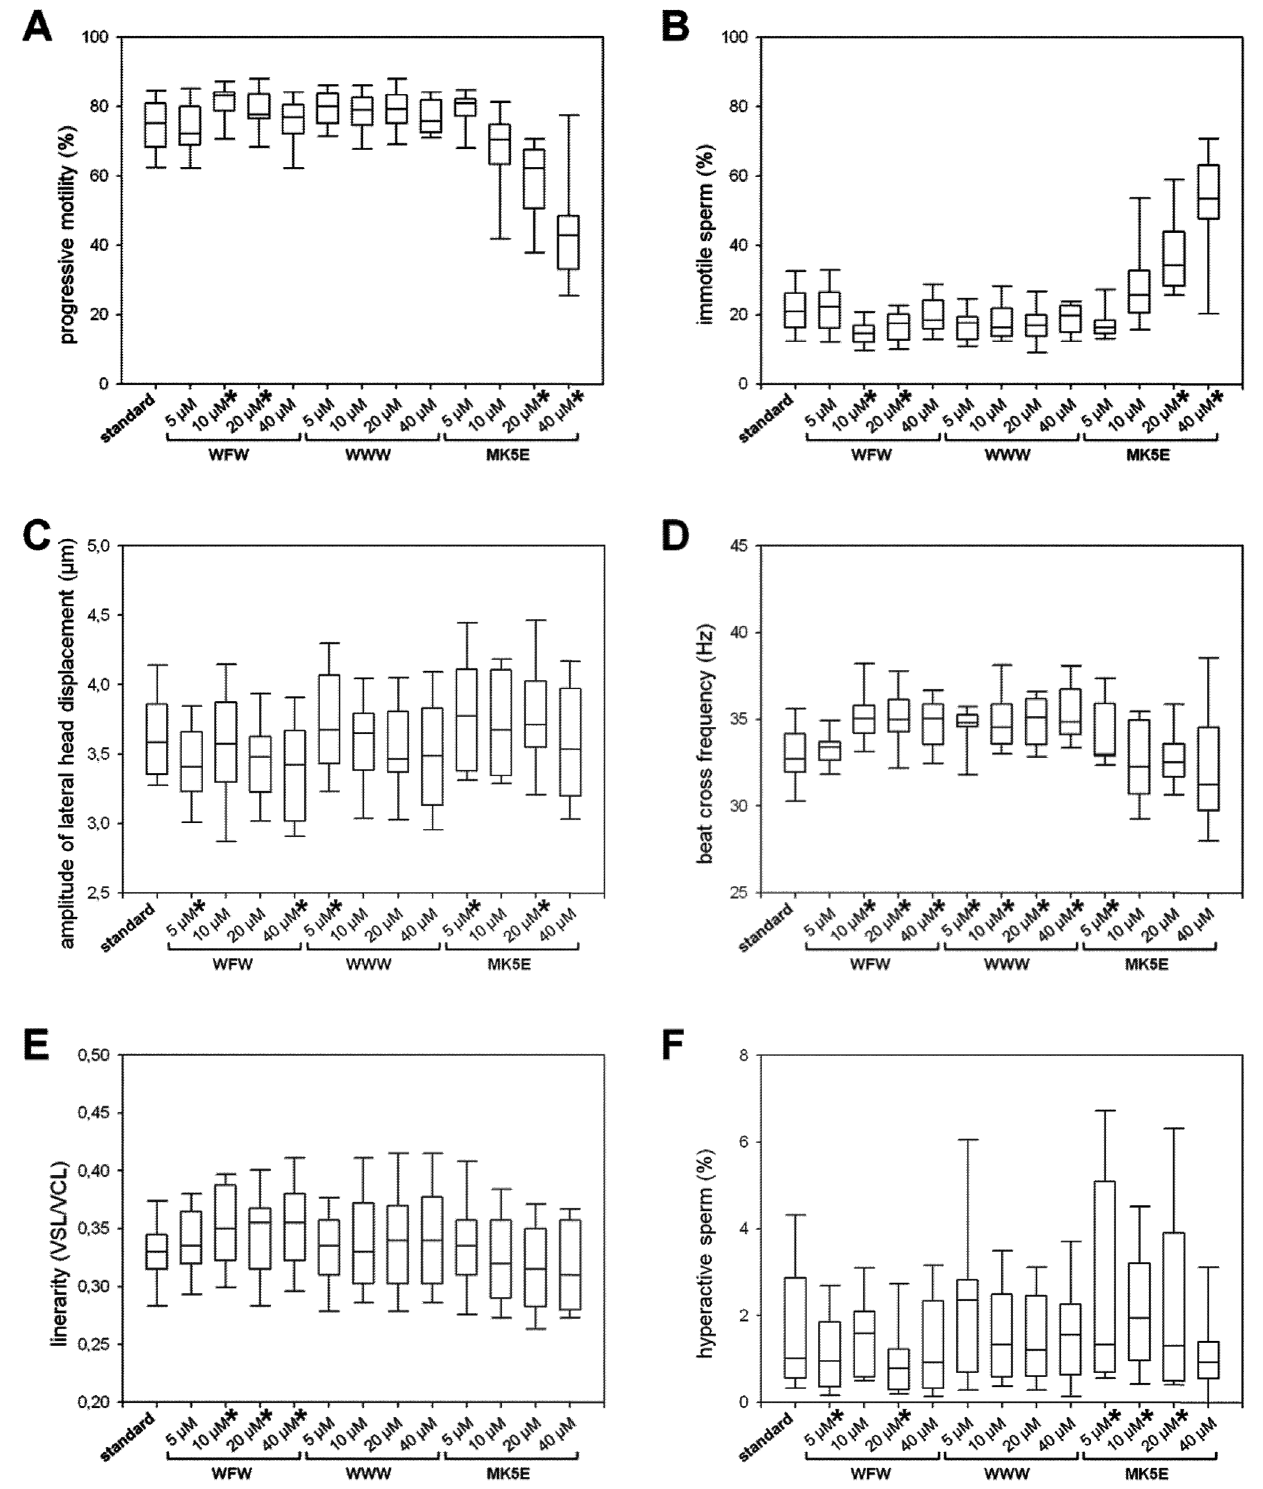
Figure 1. Motion parameters of boar spermatozoa after 5 min of incubation with increasing concentrations (5 m M, 10 m M, 20 m M, and 40 m M) of c-WFW, c-WWW, and MK5E (n=12). Before the application of peptides, semen was preserved for 24 h at 16 u C in BTS containing 250 m g/mL gentamicin (standard). * Significant difference compared to standard (see text for the exact P -values).